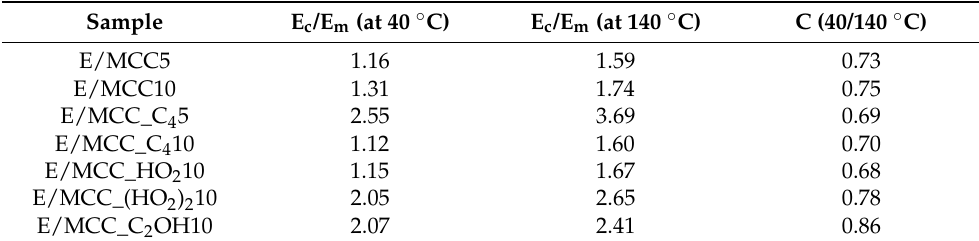
Figure 6. SEM micrographs of the crack’s initiation on the surface for neat epoxy ( a ), E/MCC5 ( b ), E/MCC_C 4 5 ( c ), E/MCC_C 4 10 ( d ), E/MCC_(HO 2 ) 2 10 ( e ), and E/MCC_C 2 OH10 ( f ) (100 × ). Table 6. Normalized storage moduli and effectiveness of fillers reinforcement (C) for the MCC/epoxy